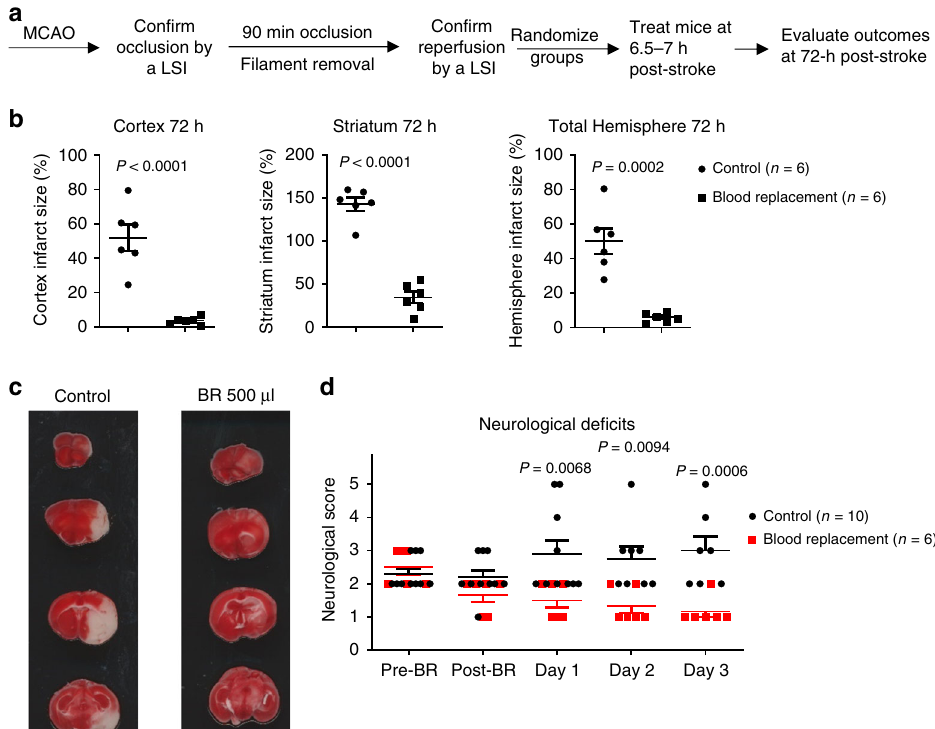
Fig. 3 Blood replacement therapy protects infarct evolution. a Experimental design. Mice underwent tMCAO for 90 min. The occlusion and reperfusion were con fi rmed by laser speckle imager (LSI). Mice were randomized into two groups: sham controls and the blood replacement (BR) group receiving 500 µ l of blood from healthy donors (3~6 months old). Blood was transfused into stroke mice at 6.5~7 h post stroke. The same volume of blood was withdrawn from the recipient stroke mice during blood transfusion. Brain infarct volumes were measured at 72 h after ischemia induction. b BR therapy reduced infarct volume in the cortex, striatum, and total hemisphere. Sham controls (circles, n = 6) and the BR group (squares, n = 6). c Representative TTC-stained coronal brain sections used for infarction analyses. d Neurological de fi cits were signi fi cantly improved in the BR group from day 1 to day 3. Sham controls (circles, n = 10) and the BR group (squares, n = 6). Data were presented as means ± SEM; P -values were calculated using two-tailed grouped analyses by Student ’ s t -test. Source data are provided as a Source Data fi